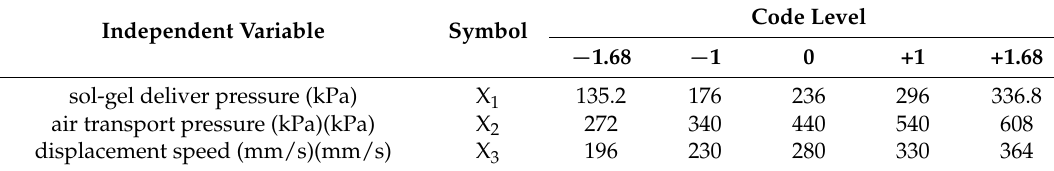
Table 2. Experimental domains and coded levels of the independent variables.